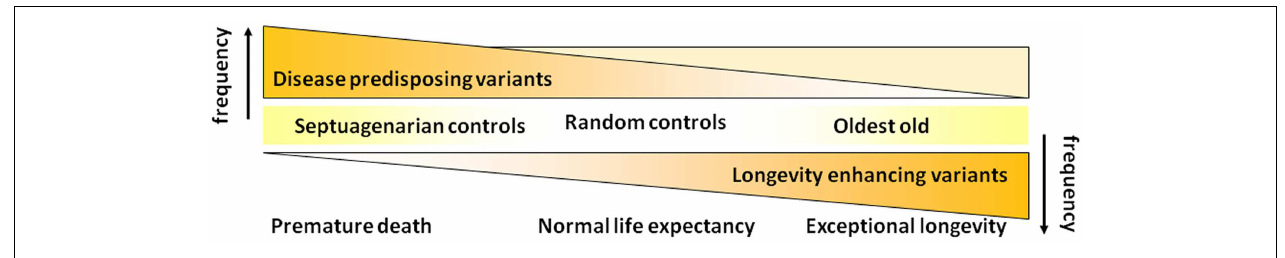
FIGURE 4 | Revised hypothesis for the prevalences of disease and longevity (or protective) associated variants with increasing age at very old